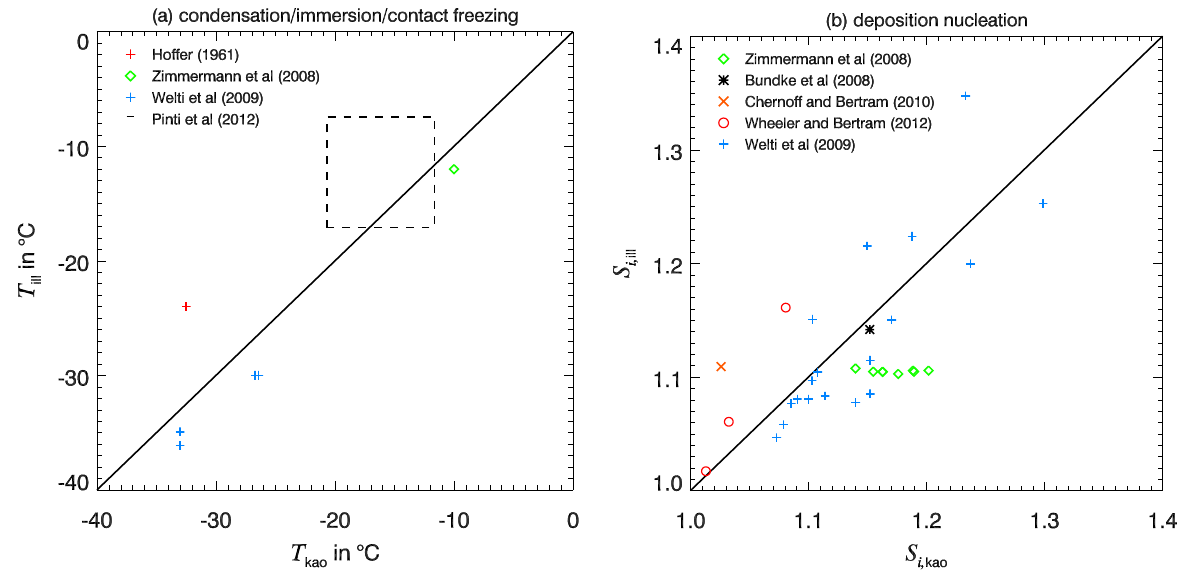
Fig. 7. (a) Freezing temperatures (onset or median) for kaolinite and illite under comparable experimental conditions. Includes immersion freezing experiments (Hoffer, 1961) and presumed condensation freezing experiments at water-supersaturated conditions (Zimmermann et al., 2008; Welti et al., 2009). The data by Welti et al. (2009) for 100 and 800nm-sized particles are interpolated to ≈ 5% supersaturation over water. Pinti et al. (2012) show results for several different kaolinites and illites, as indicated by the dashed lines. (b) Saturation ratios at nucleation onset for kaolinite and illite under comparable experimental conditions and